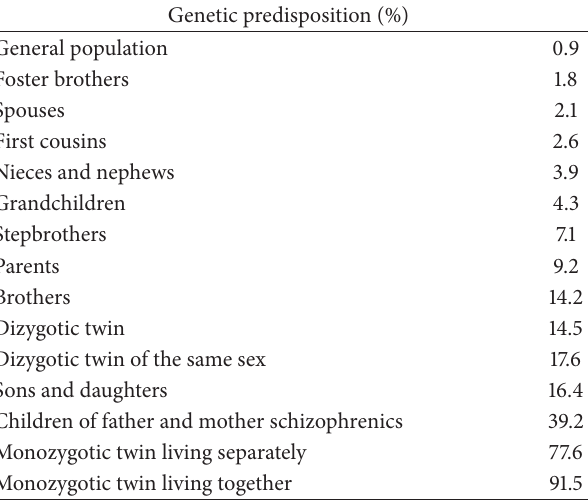
Table 2: Genetic predisposition, adapted from